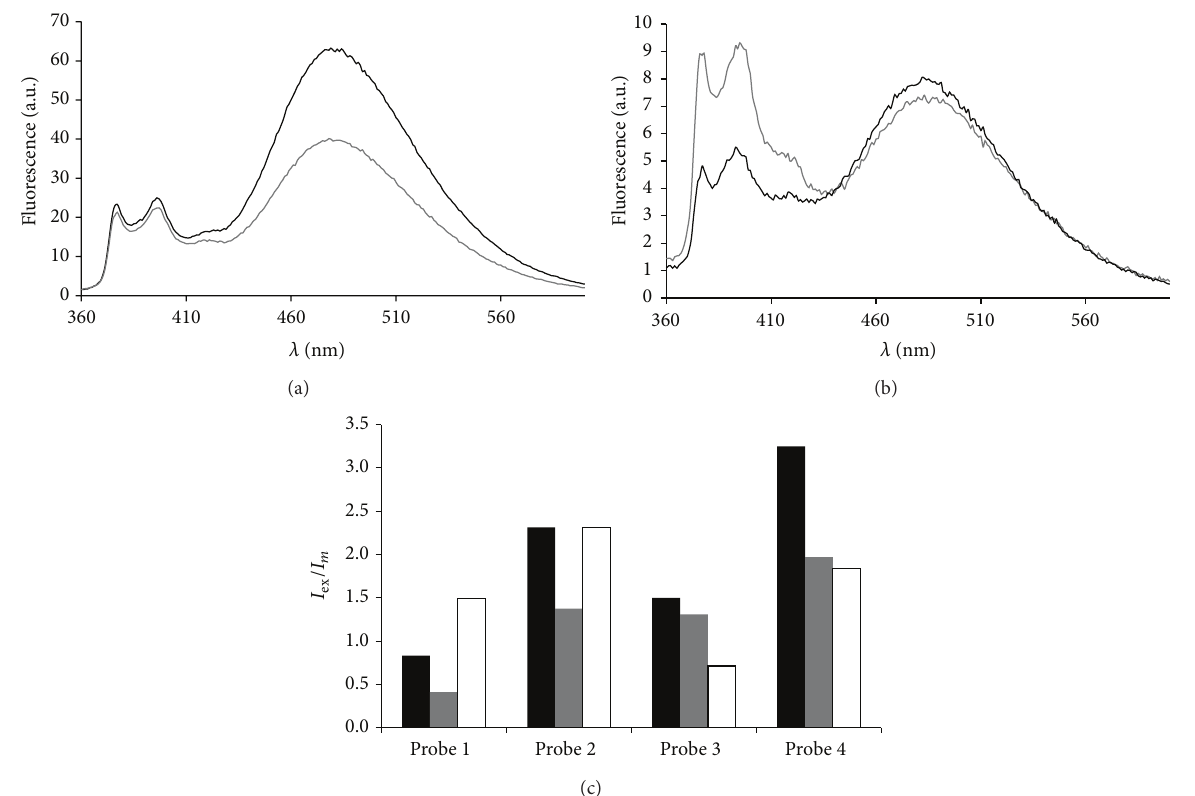
Figure 8: (a) Fluorescent spectra of (IVb+IIb) duplexes with fcDNA target (black) and Del3 target (gray), (b) fluorescent spectra of (IVa+IIa) /𝐼 duplexes with fcDNA target (black) and Del5 target (gray), (c) criterion 𝐼 𝑚 for duplexes of probe 1 (IVa+IIa), probe 2 (IVa+IIb), probe 3 ex (IVb+IIa), and probe 4 (IVb+IIb) with fully complementary fcDNA (black) and for duplexes with Del3 (gray) and Del5 (white) targets. See conditions in Figure 3. / 𝐼 𝑚 for fully complementary tandem duplexes and duplexes containing mononucleotide insertions. Table 3: Criterion 𝐼 ex Tandem fcDNA InsG InsA InsT InsC IVa+IIa 0.8 0.7